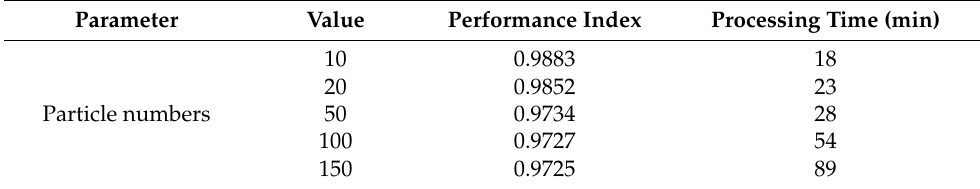
Table 2. Parameters of the optimization